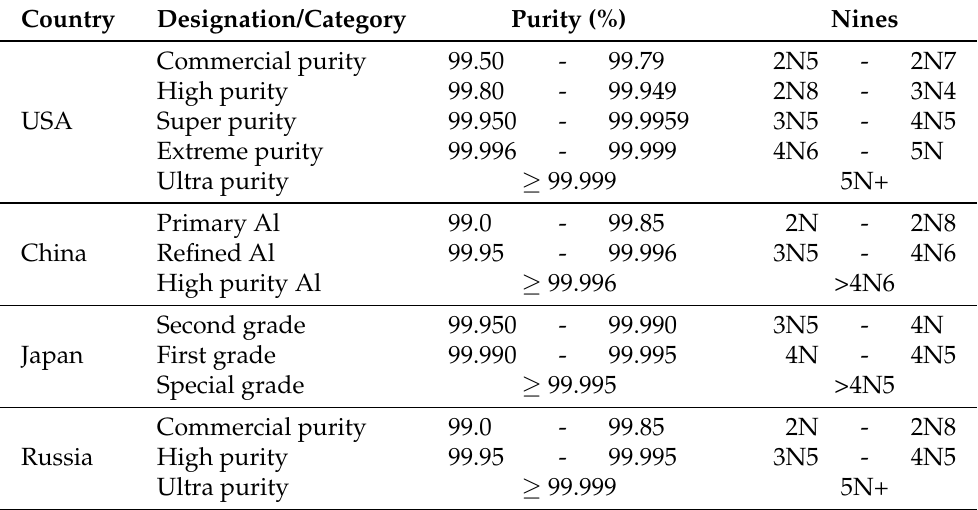
Table 1. Classification of various aluminum purity terminologies in USA, China, Russia, and Japan, data from